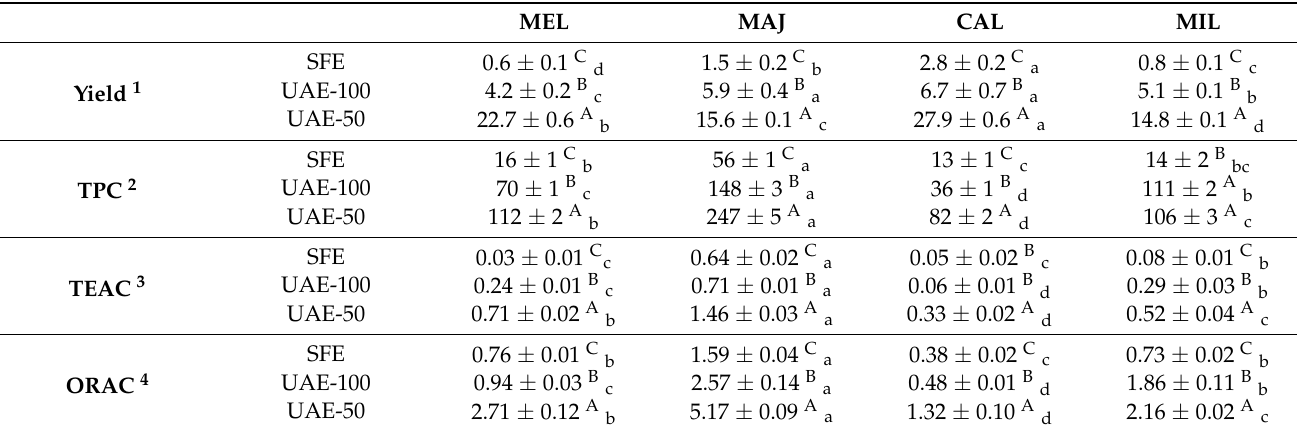
Table 1. Extraction yield, total phenolic content (TPC) and antioxidant activity of the plant extracts, obtained by supercritical fluids extraction (SFE) and ultrasound assisted extraction (UAE) techniques. MEL